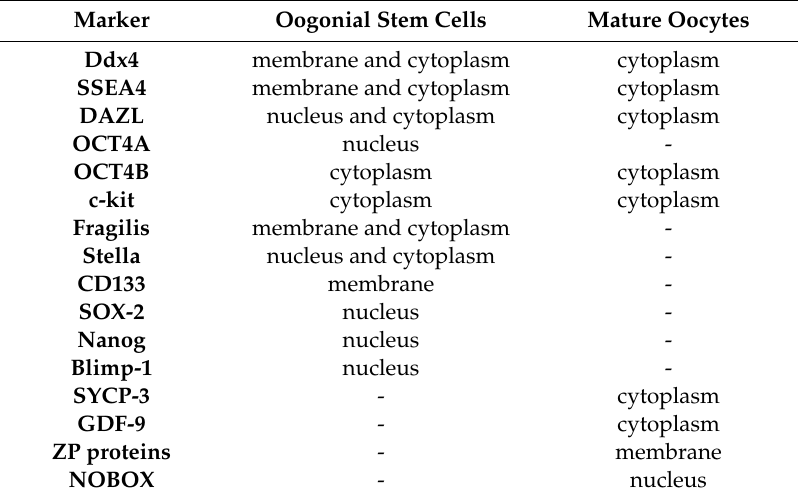
Table 1. Cell locations of shared and independently expressed molecular markers by OSCs and mature oocytes [10,13]. Marker Oogonial Stem Cells Mature Oocytes Ddx4 membrane and cytoplasm cytoplasm SSEA4 membrane and cytoplasm cytoplasm DAZL nucleus and cytoplasm cytoplasm OCT4A nucleus - OCT4B cytoplasm cytoplasm c-kit cytoplasm cytoplasm Fragilis membrane and cytoplasm - Stella nucleus and cytoplasm - CD133 membrane - SOX-2 nucleus - Nanog nucleus - Blimp-1 nucleus - SYCP-3 - cytoplasm GDF-9 - cytoplasm ZP proteins membrane NOBOX